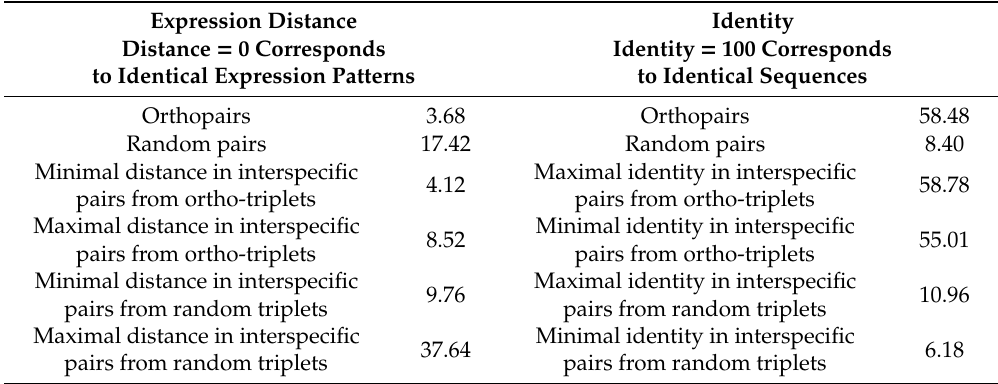
Table 2. Medians of distributions of identity and expression distance.